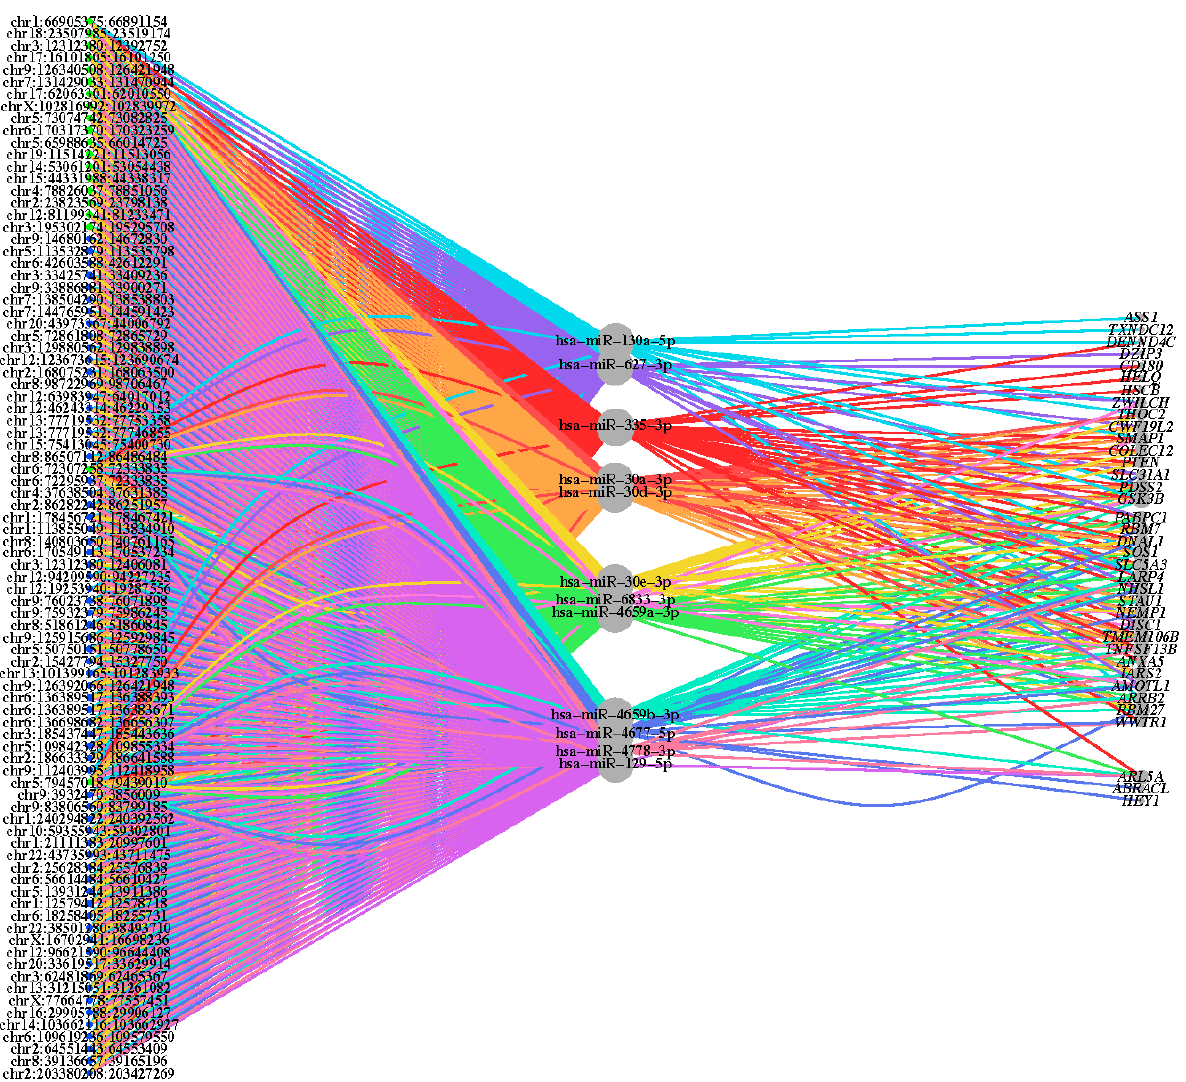
Figure 2. Network of circRNA–miRNA–mRNA interactions. A tripartite network graph displaying DE circRNAs ( left ), targeted miRNAs ( middle ) and targeted mRNAs ( right ), and the interactions between species. The node size equates to the log 2 transformation of the number of interactions associated with each node, and the interaction line color relates to the associated miRNA. The green-colored circRNAs originated from SCC tissue, and the blue-colored circRNAs originated from SCT tissue.